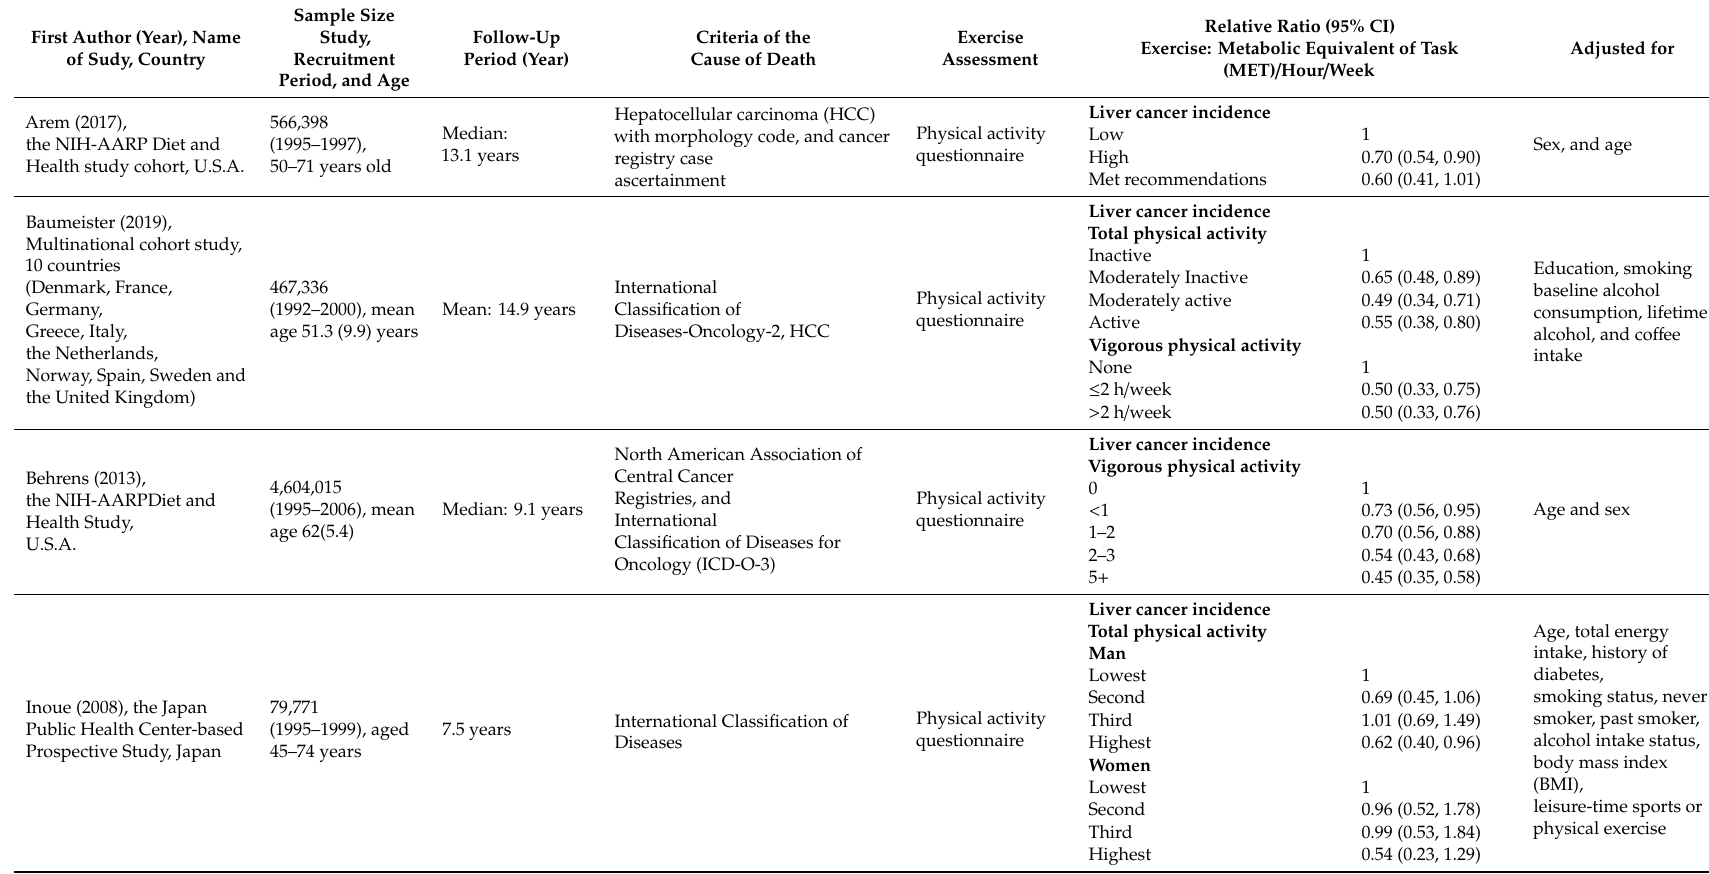
Table 1. Characteristics of selected studies: physical activity and liver cancer risks and